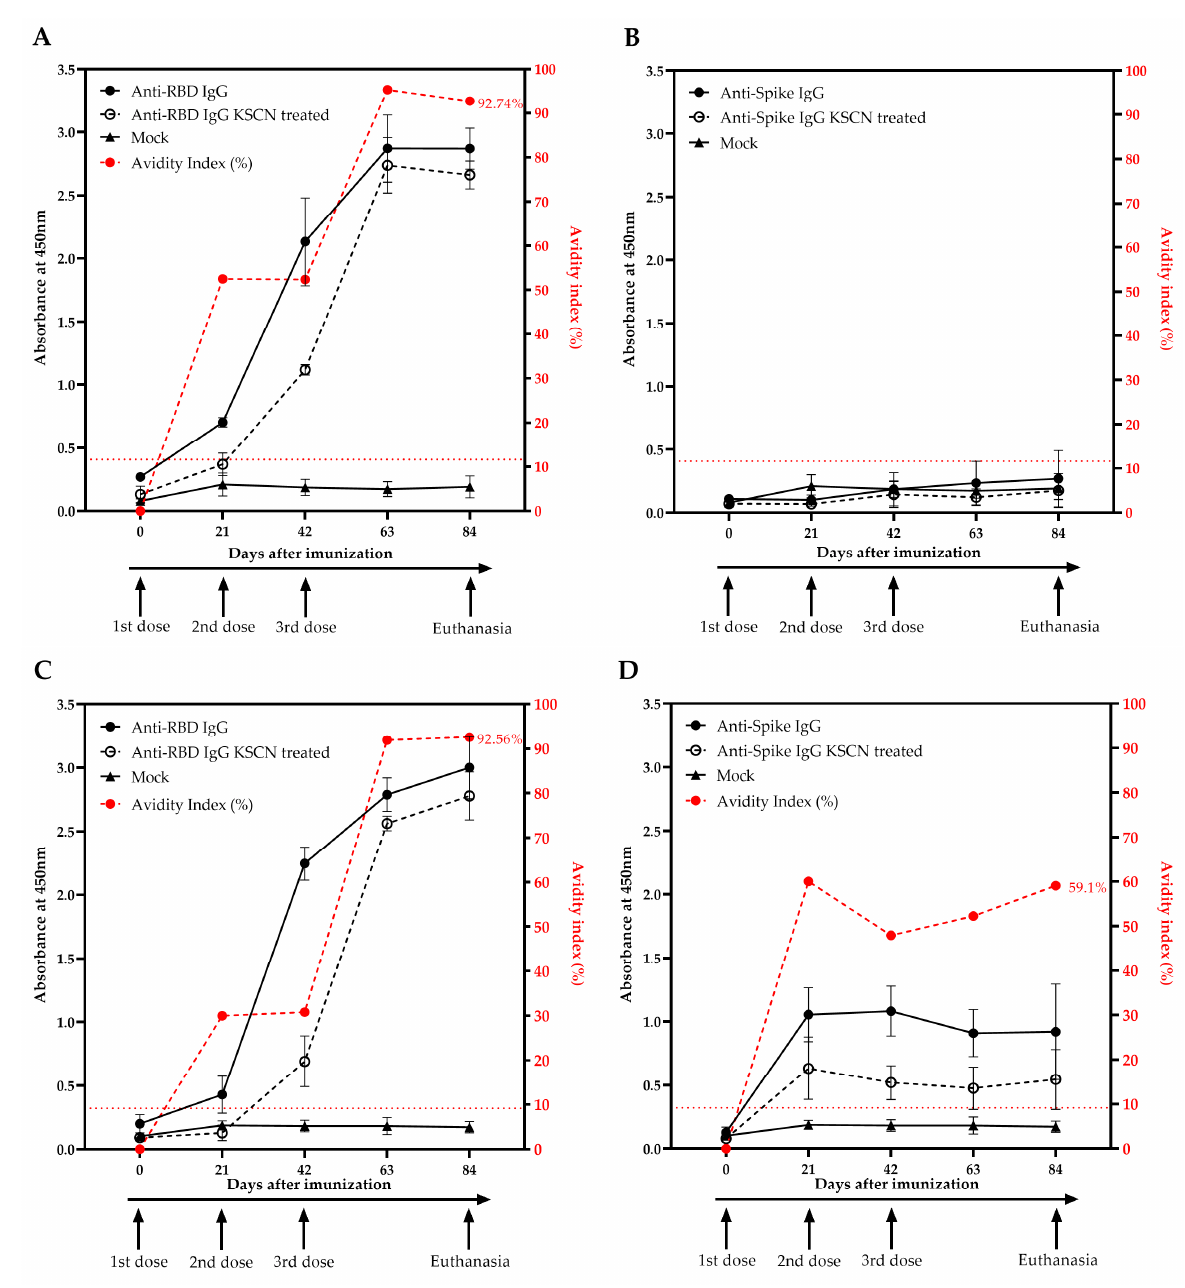
Figure 4. RBD- and spike-specific IgG antibody levels and avidity index against SARS-CoV-2. Evaluation of: ( A ) anti-RBD and ( B ) anti-spike specific-IgG and avidity against RBD as a coating protein; and ( C ) anti-RBD and ( D ) anti-spike specific-IgG and avidity against spike as coating protein. Levels of anti-RBD and anti-spike IgG (continuous black lines and dots), anti-RBD and anti-spike IgG after KSCN treatment (discontinuous black lines and circles), and mock group IgG (continuous black line and triangle). The avidity index is shown in discontinuous red lines and dots. The ELISA data are expressed as the absorbance at 450 nm and the dotted red line shows the cut-off value.